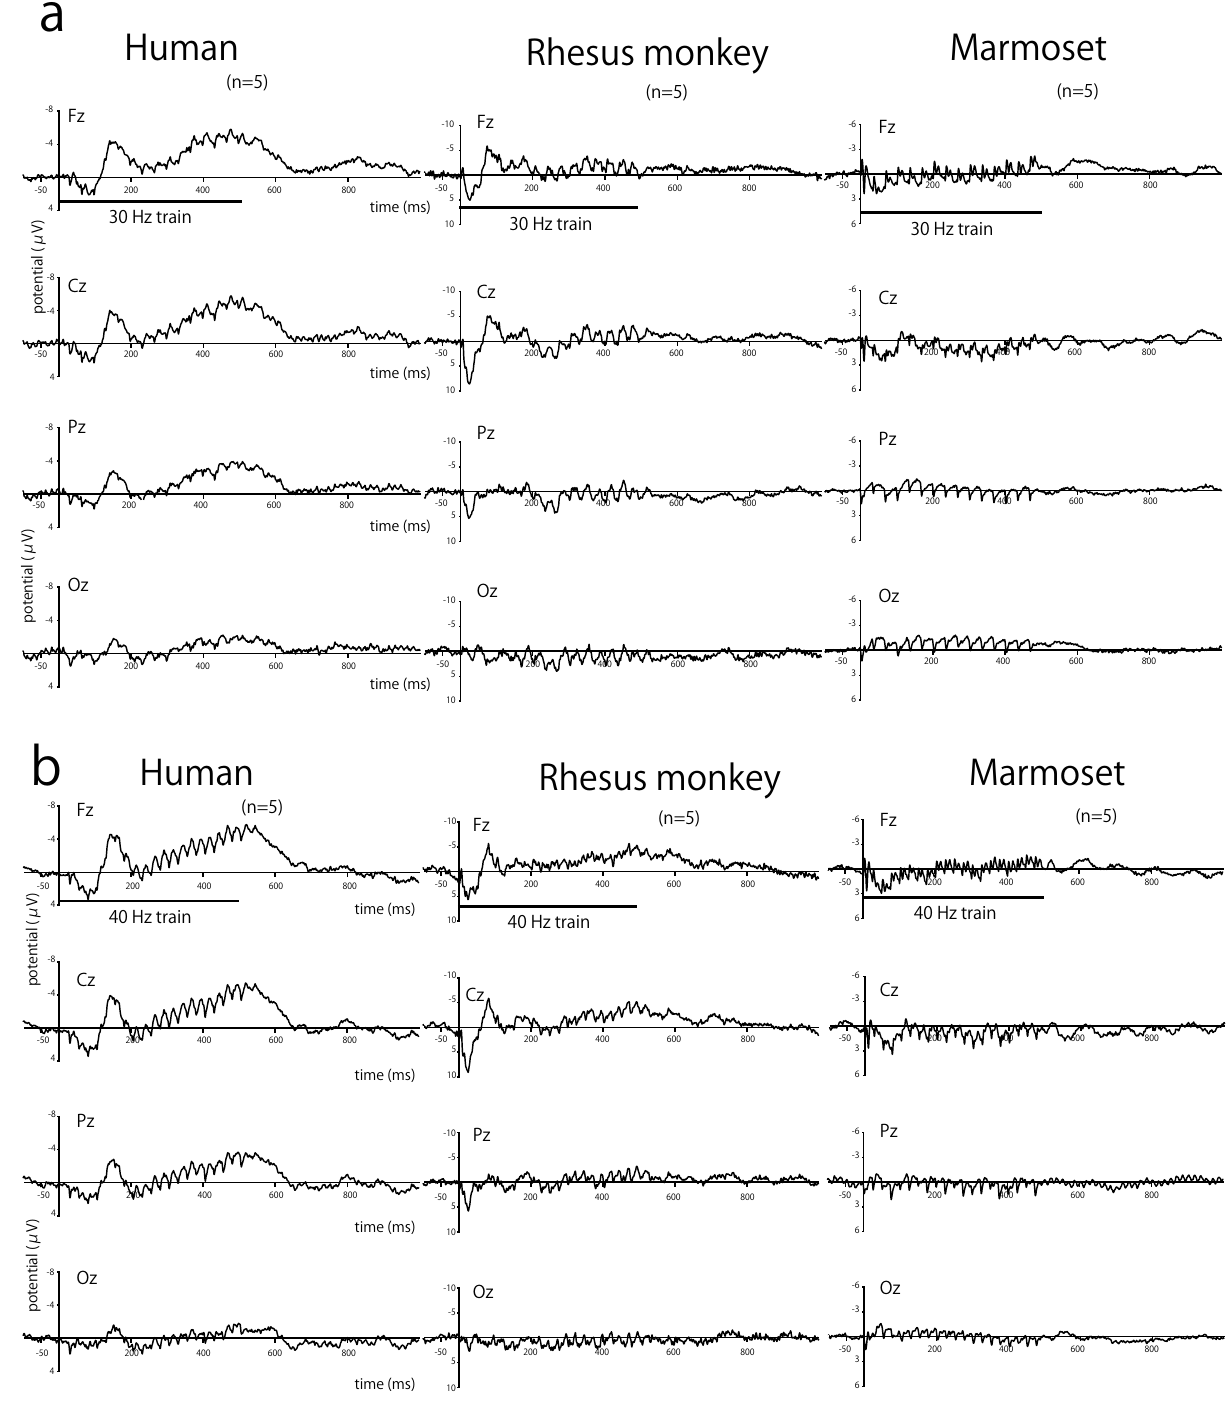
Figure 2. Grand-averaged event-related potentials (ERPs) to ( a ) 30 Hz, ( b ) 40 Hz, and ( c ) 80 Hz click trains for humans (left), rhesus monkeys (middle), and common marmosets (right column; n = 5). The vertical bar indicates the period for the train